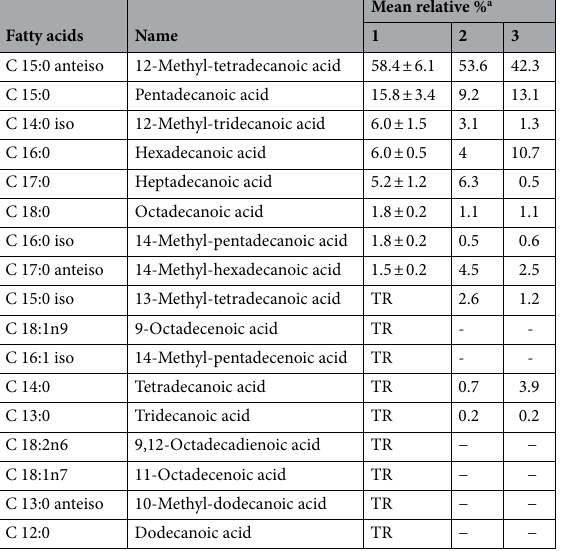
Table 2. Cellular fatty acid composition (%) of Akkermansia massiliensis strain Marseille-P6666, Akkermansia muciniphila strain ATCC BAA-835 T and Akkermansia glycaniphila strain Pyt T .